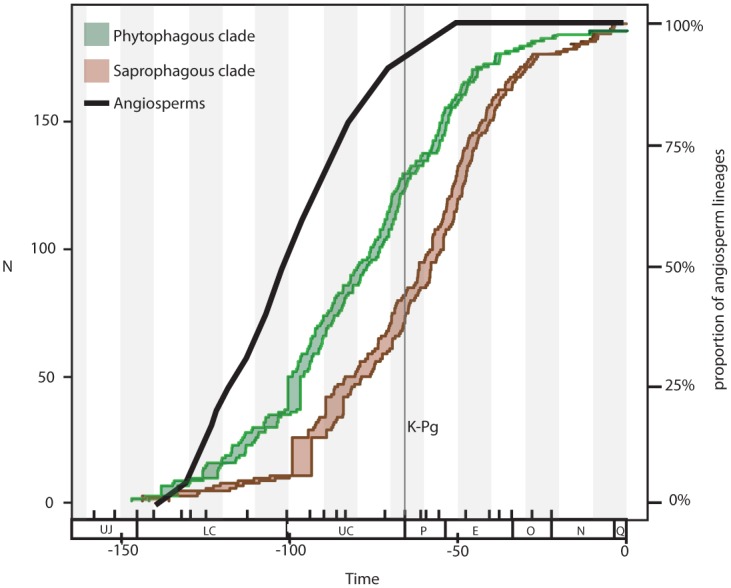
Lineage through time (LTT) plots of scarab lineages.LTTs are compared to the proportion of extant crown group angiosperm lineages as per Schneider et al. [115]. Shaded areas represent congruent estimates from analyses CS2, CS3, CSiii and CSiv estimated by Penalized Likelihood methods with divergence maxima plotted from CS2 and minima from CSiii.